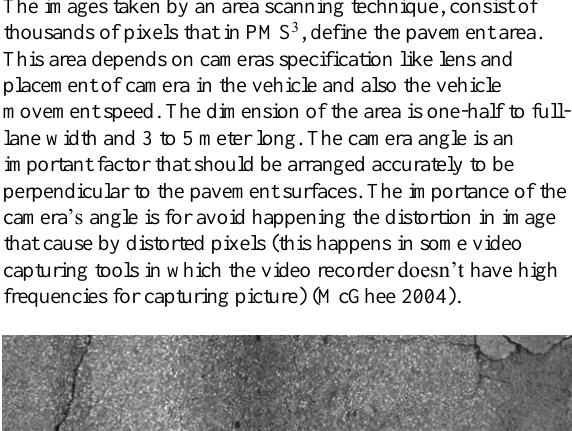
Figure 2 .The effect of shadow in the left side, Line scan pavement image (McGhee 2004)